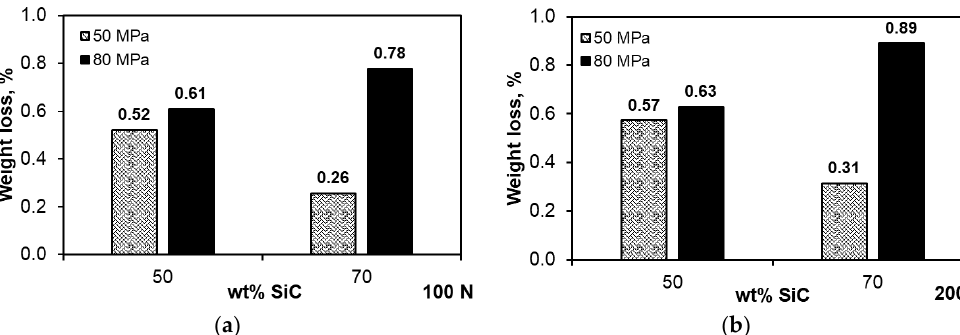
 Figure 10. Al-70SiC specimen surfaces after tribological tests.